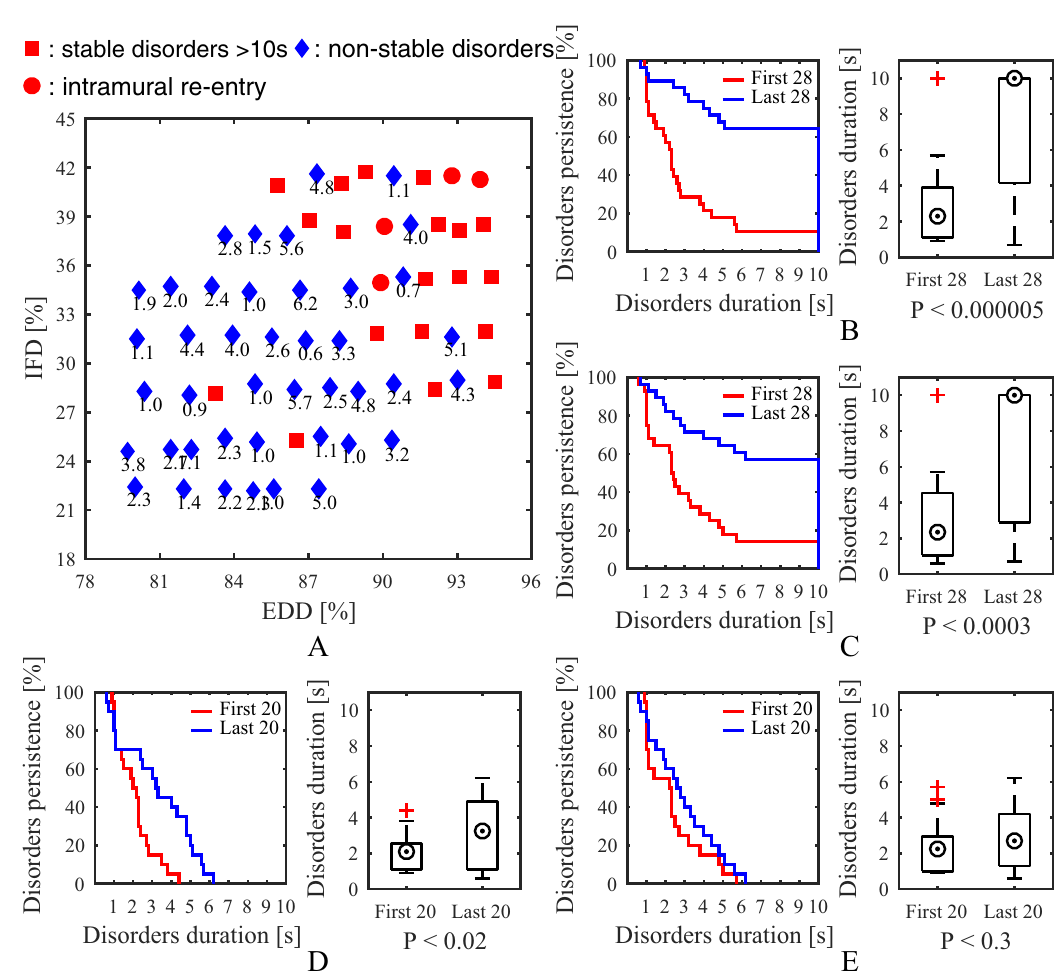
Fig 6. Simulation results of the stochastic group. (A) A time map of 65 simulations showing effects of intramural fibrosis and endo- epicardial dissociation on stability. Kaplan-Meier curves, boxplots, and P-values show differences between (B) the first 28 and last 28 simulations after ranking based on endo-epicardial dissociation degree, (C) the first 28 and last 28 simulations after ranking based on intramural fibrosis degree, (D) the first 20 and last 20 non-stable simulations after ranking based on endo-epicardial dissociation degree, and (E) the first 20 and last 20 non-stable simulations after ranking based on intramural fibrosis degree. IFD is the intramural fibrosis degree and EDD is the endo-epicardial dissociation degree.